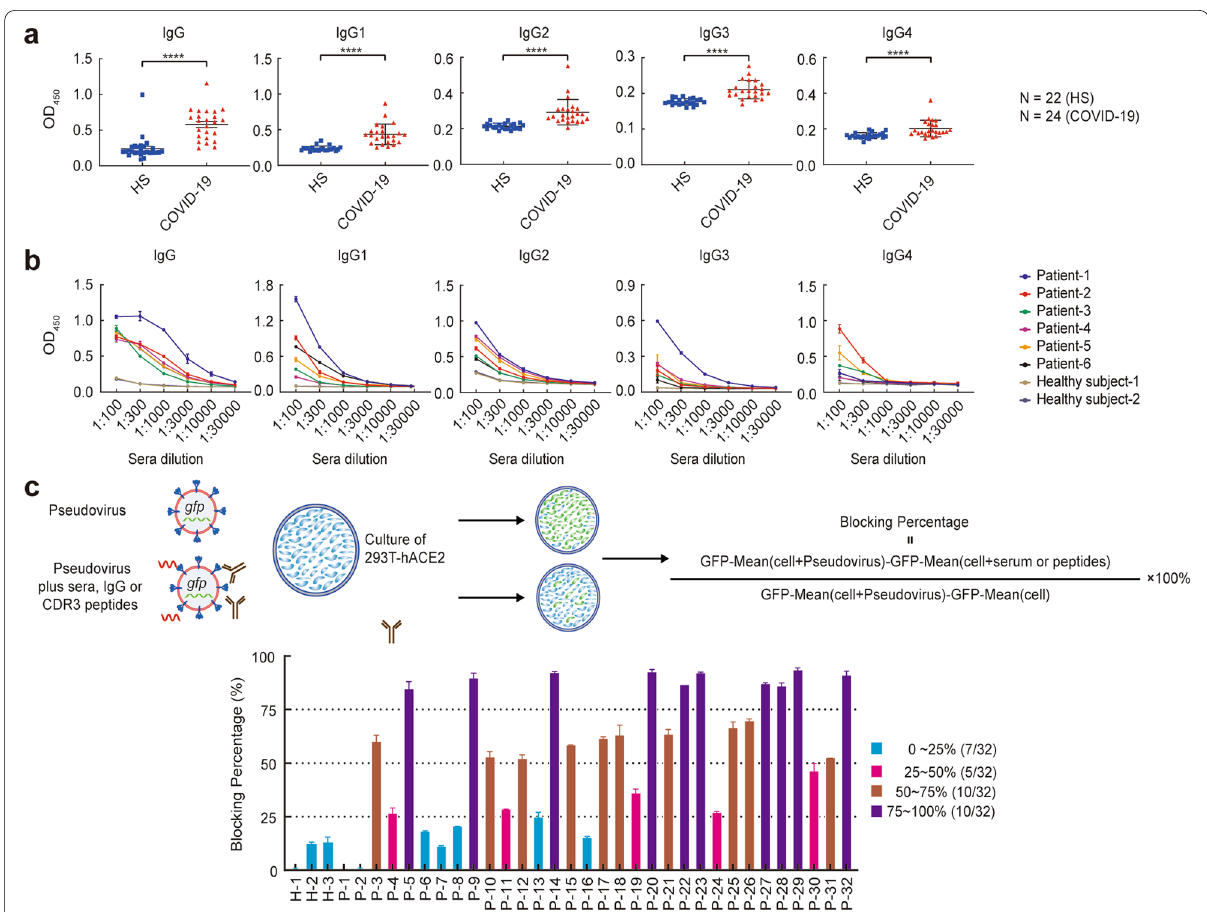
Fig. 2 Neutralization ability of IgG in sera from COVID-19 patients of 2 weeks convalescence. a The sera from healthy subjects (HS) and COVID-19 convalescent were diluted 100x and detected S1 protein-specific IgG1, IgG2, IgG3, IgG4, and total S1 protein-specific IgG by ELISA. A microplate reader measured the absorbance at 450 nm. b Diluted sera (from 1:100 to 1:30000) were detected by ELISA to assure the S1 protein-specific IgG, IgG1, IgG2, IgG3, and IgG4. A microplate reader measured the absorbance at 450 nm. c The pseudovirus neutralization assays were performed using hACE2-expressed HEK293 cell lines. SARS-CoV-2 pseudoviruses containing GFP encoding gene were mixed with CDR3 peptides, purified IgG, and diluted sera were added to the well. After 18 hours of cell culture, the GFP-FITC was detected by flow cytometry. The neutralization efficiency of peptides/IgG/sera against SARS-CoV-2 pseudovirus was determined as [(Positive control MFI- experimental MFI)/(Positive control MFI- Negative control MFI)] 100. d. The sera from 3 healthy subjects (HS) and 32 COVID-19 convalescents were diluted 160x and detected their ability to block × pseudovirus by the method described above